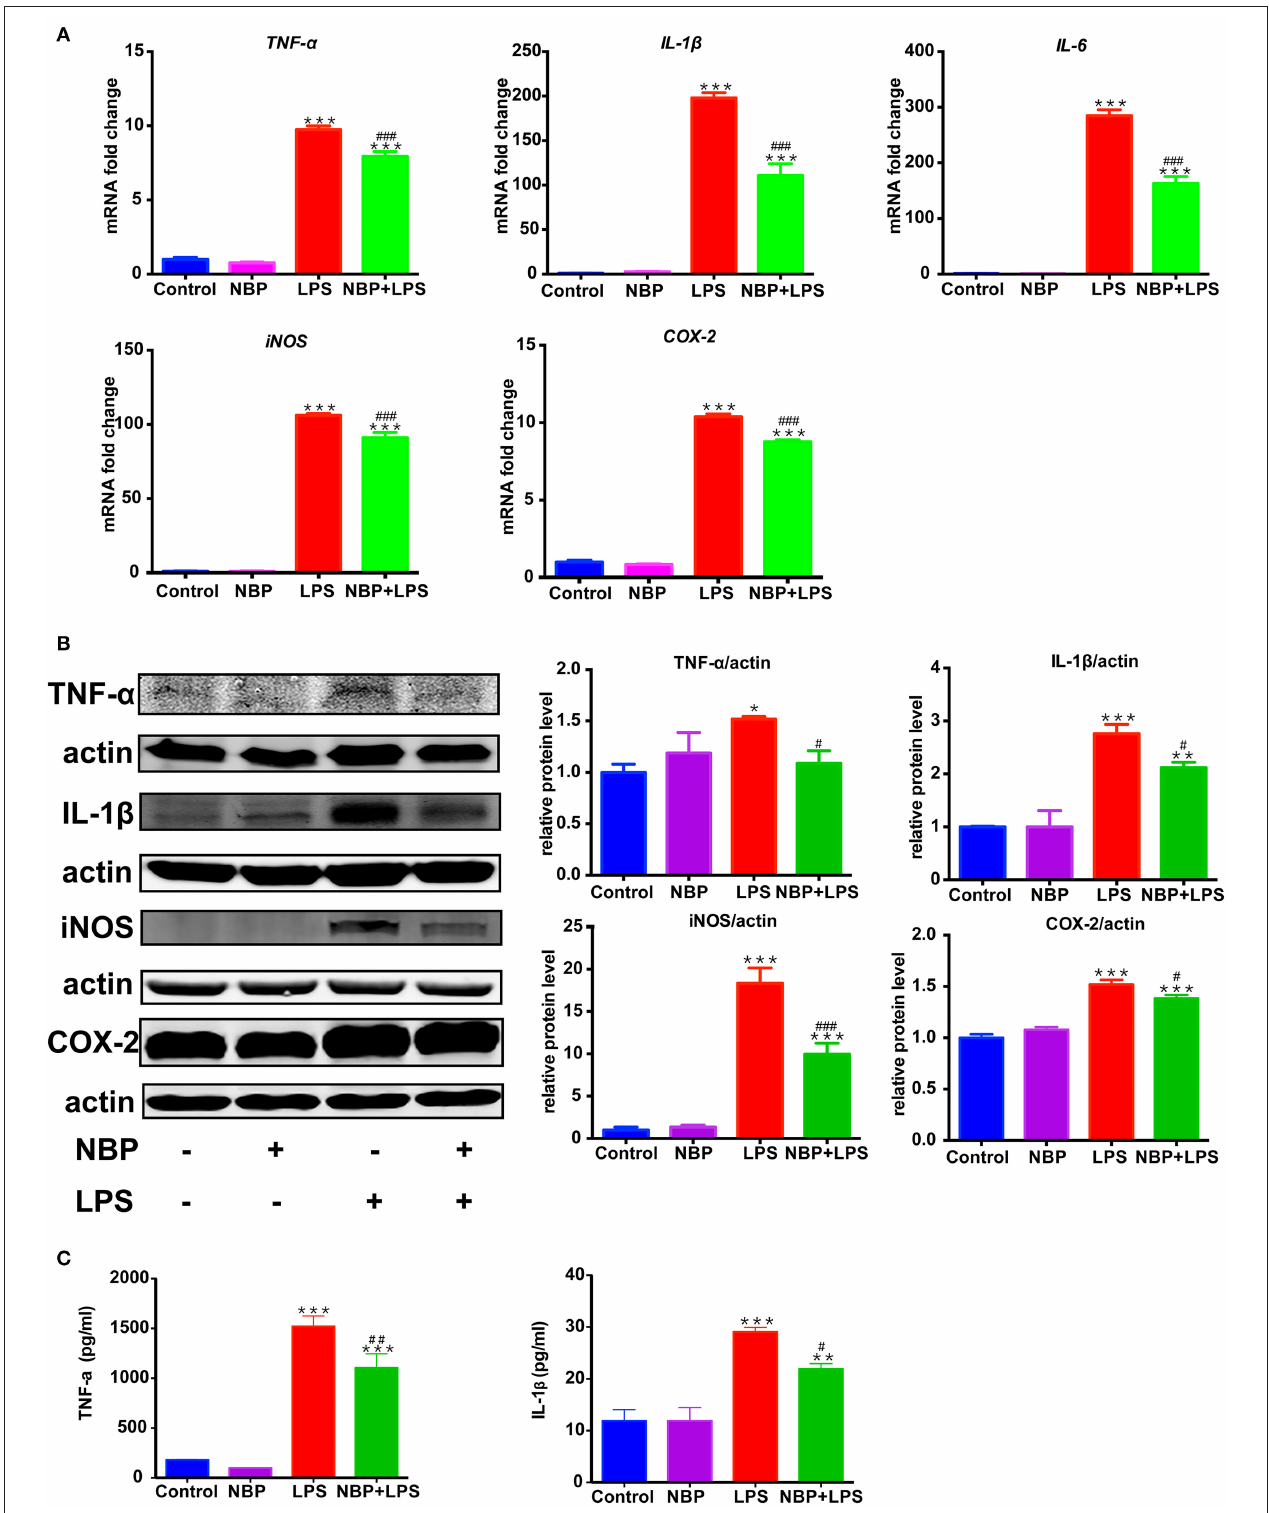
FIGURE 6 | NBP reduced pro-inflammatory molecules expression in LPS-stimulated BV-2 cells. BV-2 cells were pretreated with NBP (0 or 100 µ M) for 1h followed by LPS (0 or 100ng/ml) for 6h and total RNA was isolated. To measure cellular protein expression or cytokines level in supernatants, time for LPS treatment was 24h. (A) The mRNA expression of IL-1 β , IL-6, TNF-a, iNOS and COX-2 was analyzed by RT-PCR and normalized to that of β -actin . (B) The protein level of TNF- α , IL-1 β , iNOS and COX2 was analyzed by Western Blot. (C) The level of TNF- α and IL-1 β in supernatants was assayed by ELISA kit. All data are presented as means ± SEM ( n = 3). * p < 0.05, ** p < 0.01, *** p < 0.001, compared with the Control group; # p < 0.05, ## p < 0.01, ### p < 0.001, compared with the LPS group.